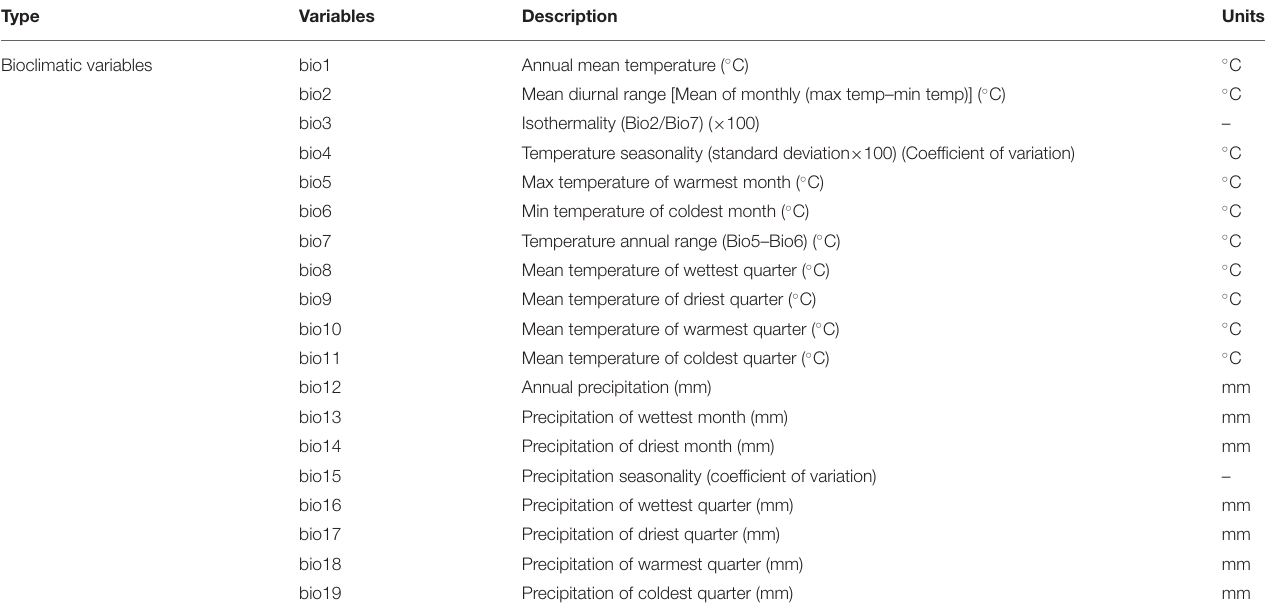
TABLE 1 | Bioclimatic variables in this study.